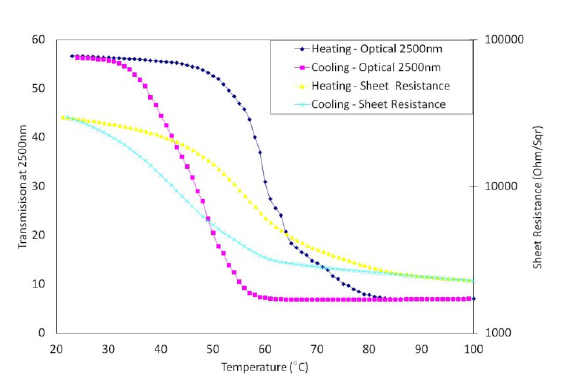
Fig. 9. Typical hysteresis plot of the metal-insulator phase change in VO 2 optical transmission at 2500 nm along with the coincident change in electrical sheet resistance